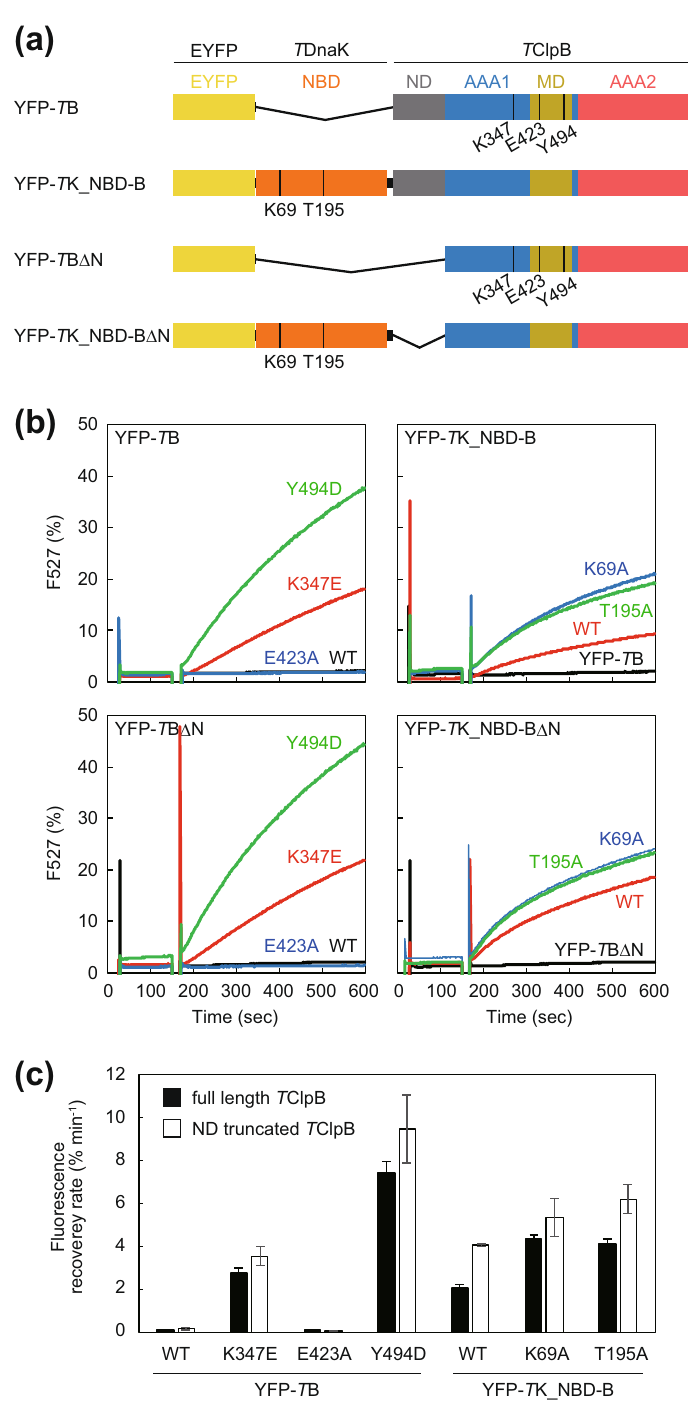
Figure 5. Disaggregation reaction of aggregated EYFP tethered by a chaperone. ( a ) Schematic drawing of the construction of YFP- T B and YFP- T K_NBD-B are shown. ( b ) YFP- T B (left panel), YFP- T K_NBD-B (right panel), and their mutants (6.0 μ M monomer) were heat treated at 80 °C for 15 min and the EYFP portions of these proteins were aggregated. The heat-treated fusion proteins were diluted to 0.3 μ M monomer, incubated at 55 °C, and the fluorescence at 527 nm (excitation 513 nm) was monitored. After 2 min incubation, ATP (final concentration was 5 mM) was added and the fluorescence monitoring was continued. Fluorescence intensities are shown as a percentage of that prior to heat aggregation. ( c ) Initial rates of the recovery of the fluorescence were calculated from the measurements shown in ( b ). Error bars represent standard deviations of three or more independent measurements. WT,